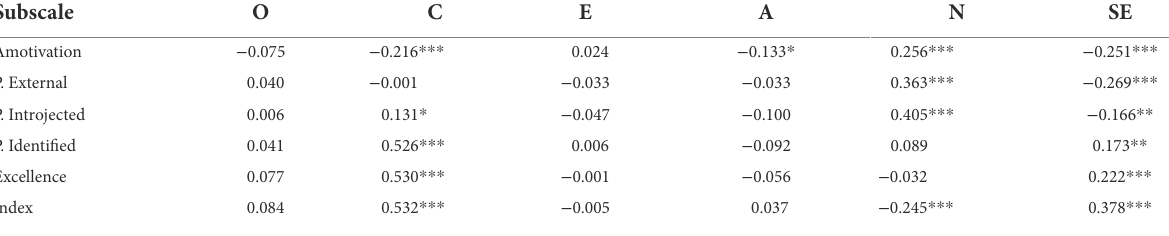
TABLE 12 Correlations Between the MPSES and the BFI-15 and Self-Esteem Item, Study 2.